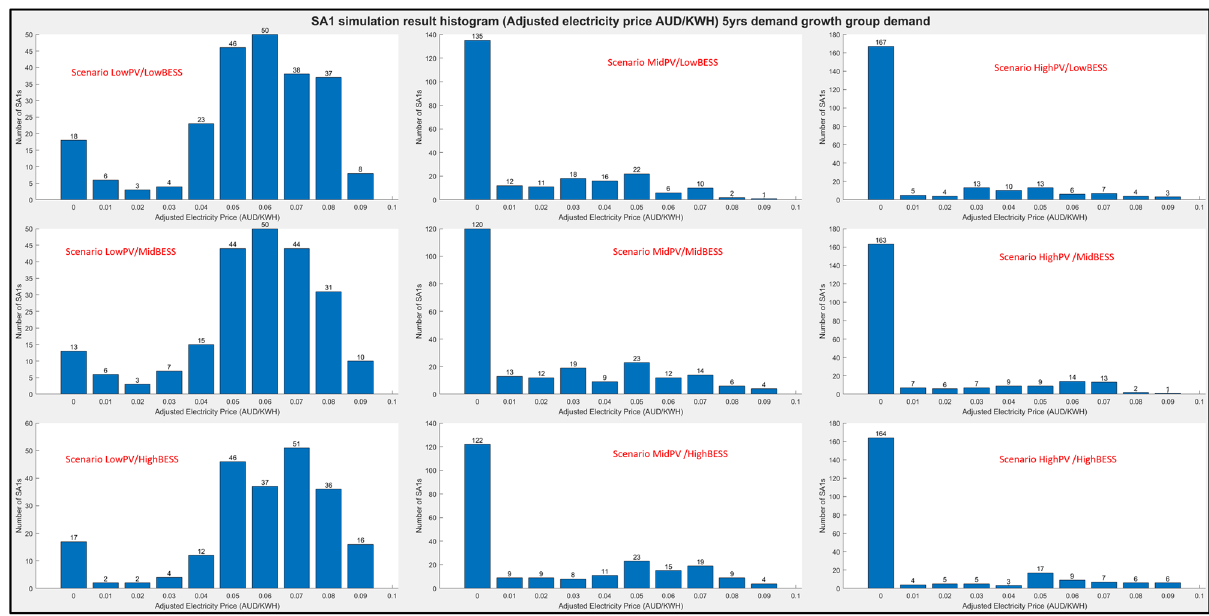
Figure 10. Histogram plots of SA1 simulation results for adjusted electricity price.